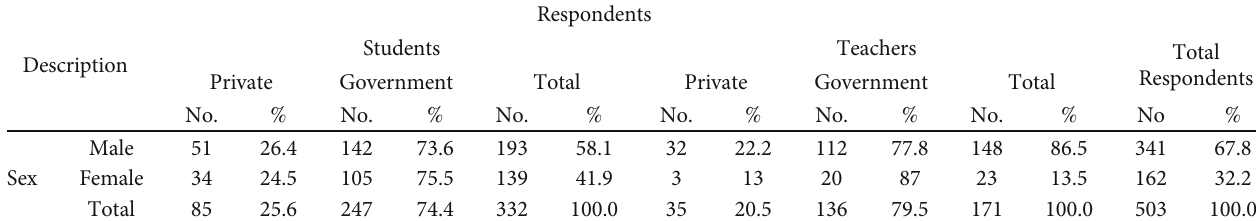
T ABLE 1: Sex versus school-type cross-tabulation.